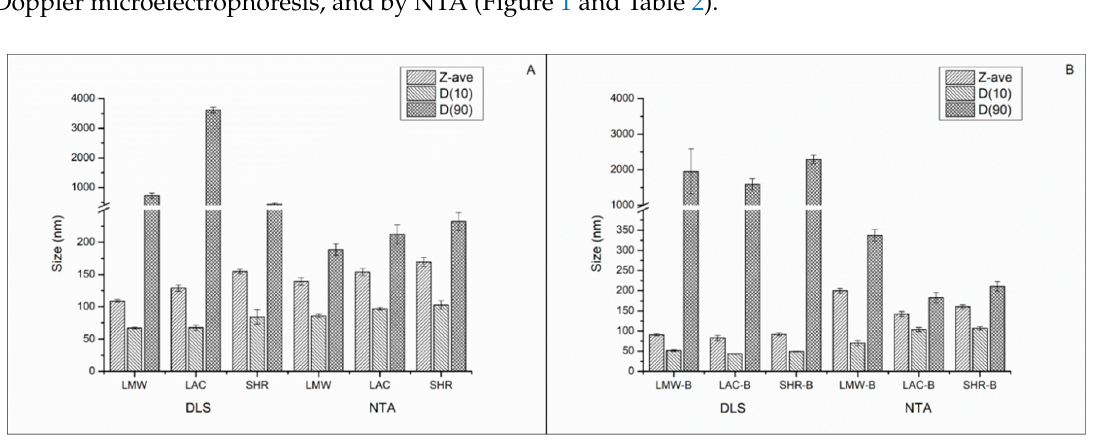
Figure 1. Chitosan ( A ) and chitosan-bromelain ( B ) nanoparticles mean size obtained by DLS and nanoparticle tracking analysis (NTA). LMW = low molecular weight chitosan nanoparticles; LAC = chitosan oligosaccharide lactate nanoparticles; SHR = chitosan from shrimp shells nanoparticles; B = bromelain; Z-ave = mean diameter; D(10) = size below which 10% of material is contained; D(90) = size up to and including which 90% of material is contained. Table 2. Polydispersity index and zeta potential of chitosan and chitosan–bromelain nanoparticles obtained by DLS, laser Doppler microelectrophoresis, and